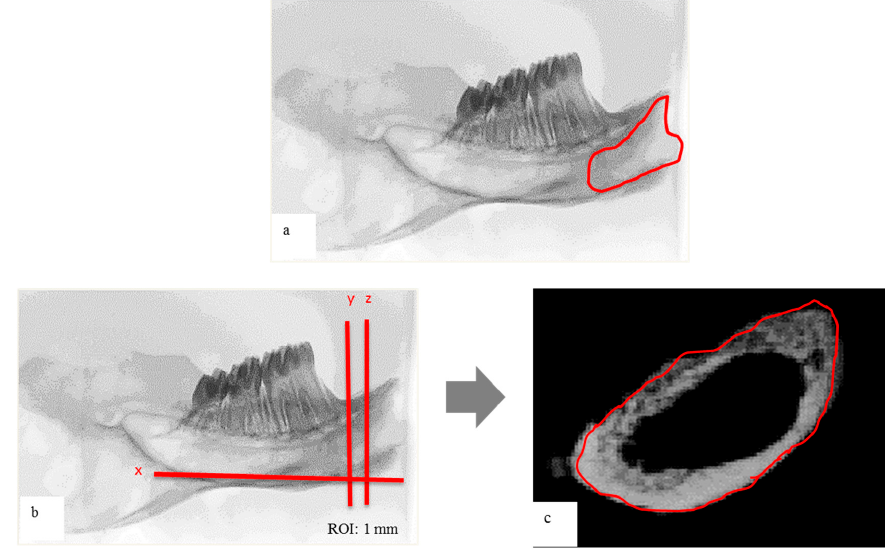
Figure 2. Micro-computed tomography (micro-CT) analysis: ( a ) radiographic image in the horizontal plane; ( b ) radiographic image in the vertical plane (x: mandibular plane, y: plane y; z: plane z), region of interest (ROI) was determined as 1 mm of bone thickness between y and z; ( c ) reconstructed image of ROI before analysis.